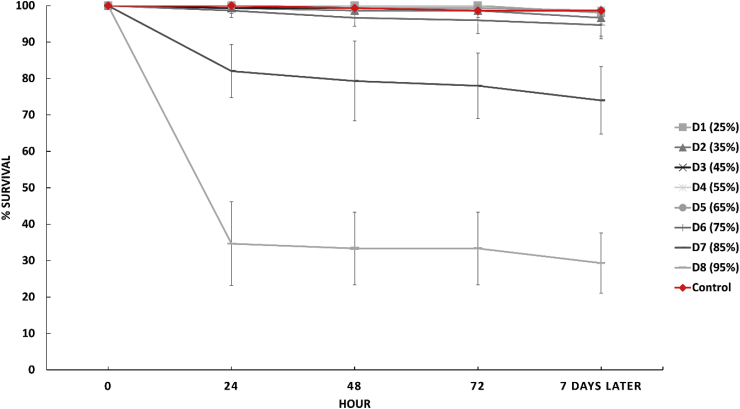
Average larval survival percentage on Control and D1 to D8 (waragi content) with SD.